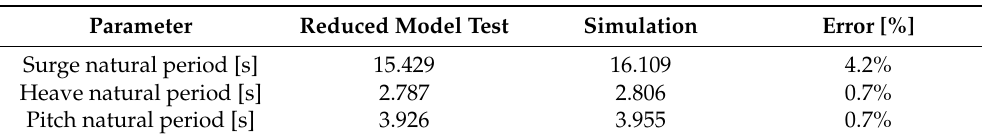
Table 8. Comparison of the reduced model test and the simulation results of the 10 MW FOWT motion natural